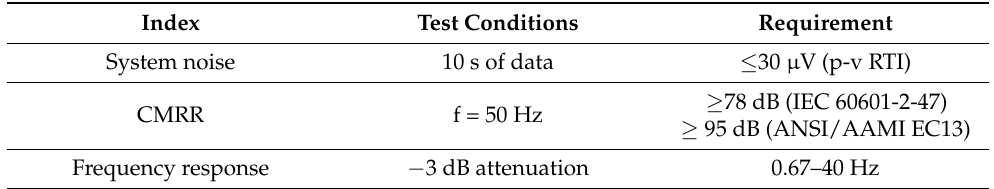
Table 1. Performance Requirements.